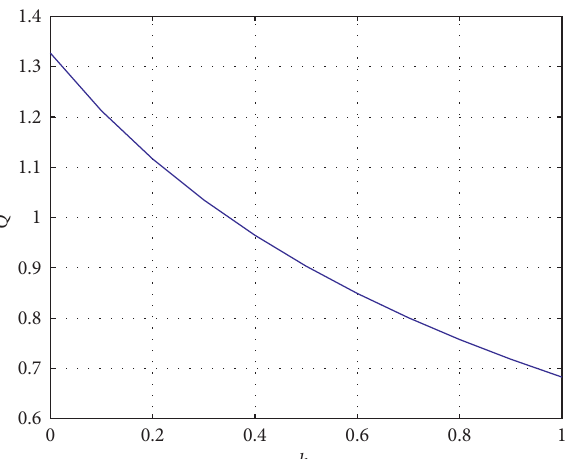
Q ∗ under RMI mode with stochastic demand in the water r on the optimal inventory quantity